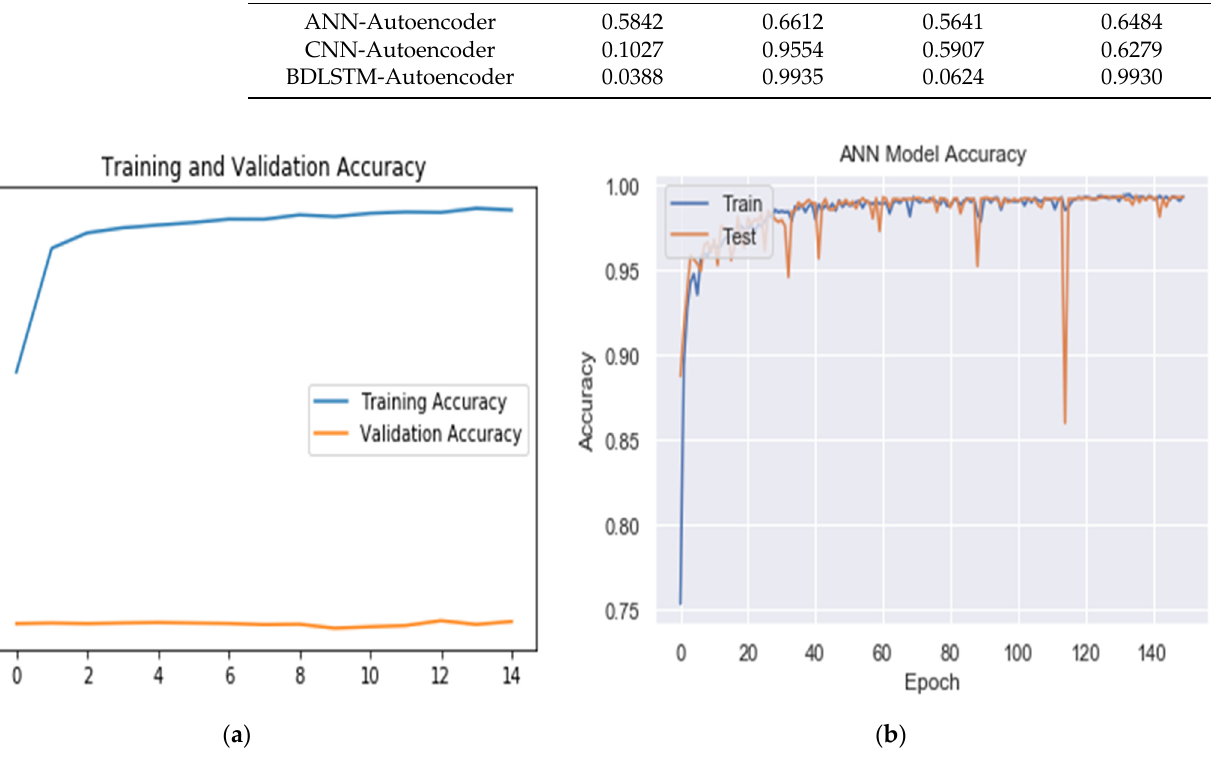
Figure 3. Accuracy results for ( a ) the CNN-autoencoder model, and ( b ) the BDLSTM-autoencoder